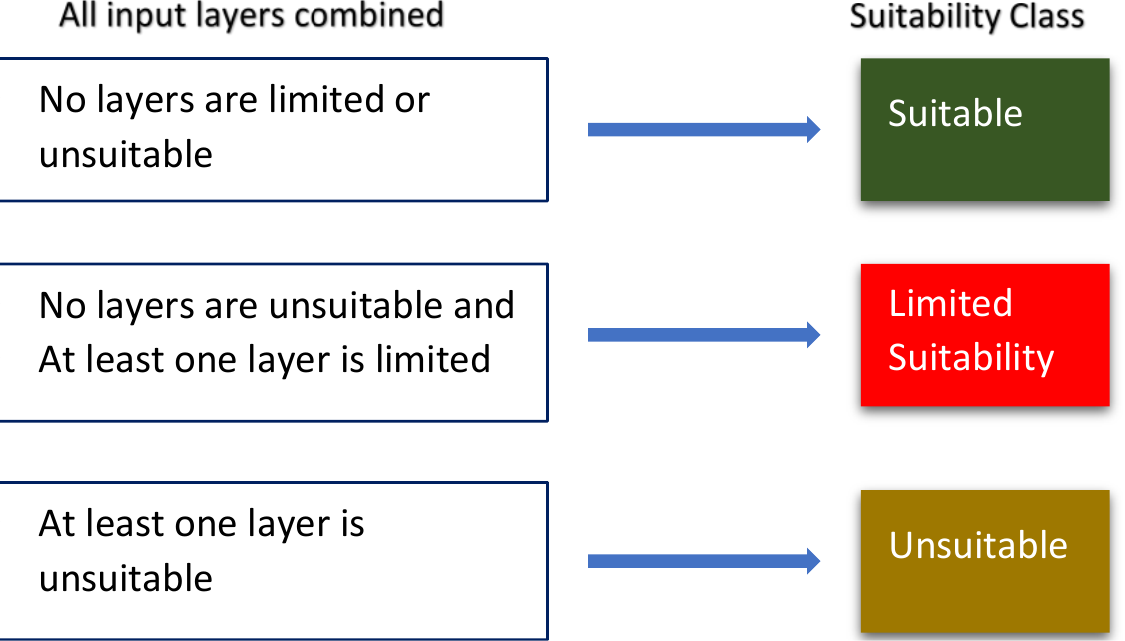
Figure 2. The methods used to combine the input layers (source: Bell et al. [32]).